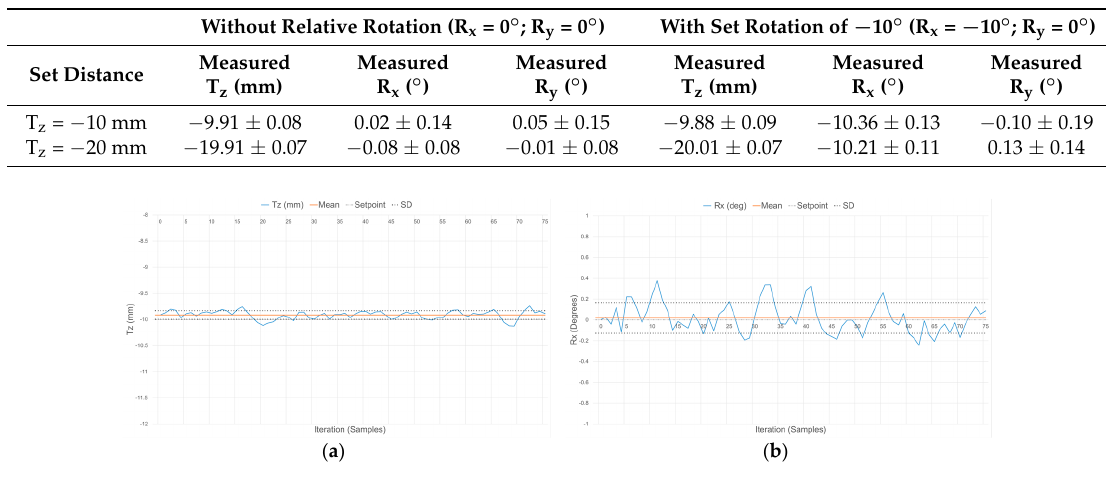
Table 4. 3-DOF transformation parameters measured when operating at two different levels of compression of the compliant plate in contact with a planar surface that is either parallel to the compliant wrist (0°), or angled with a − 10° rotation about X.